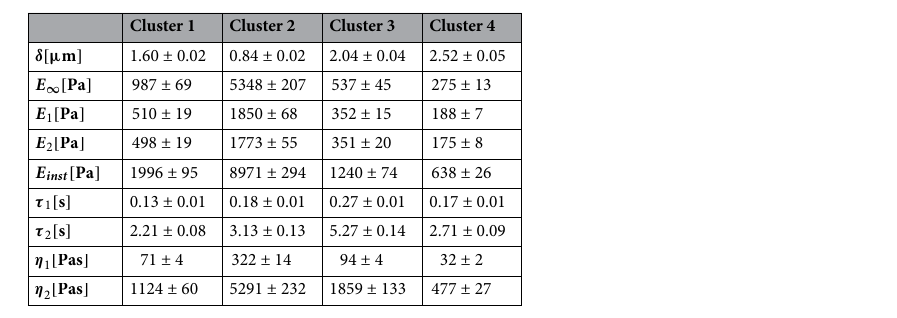
Table 3. Analysis of the four cluster with respect to the determined viscoelastic properties. The values shown are mean values ± the standard